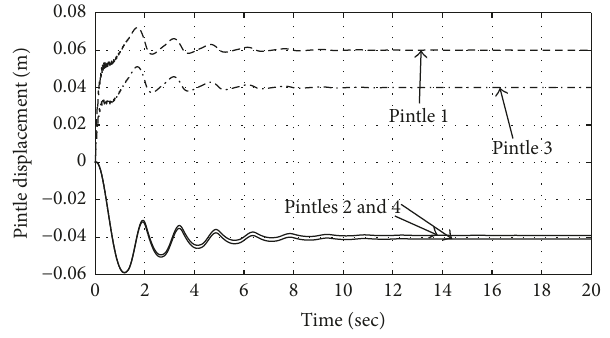
Figure 17: Simulation results, case